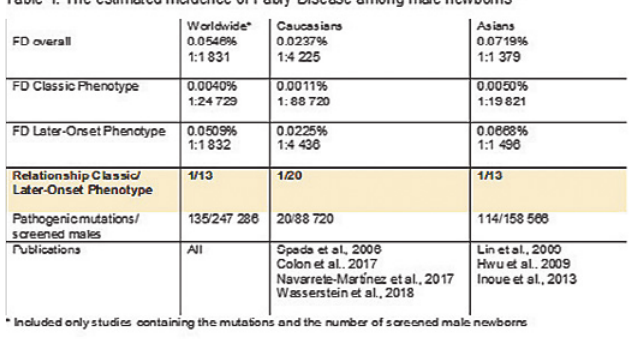
Table 1: The estimated incidence of fabry disease among male newborns.